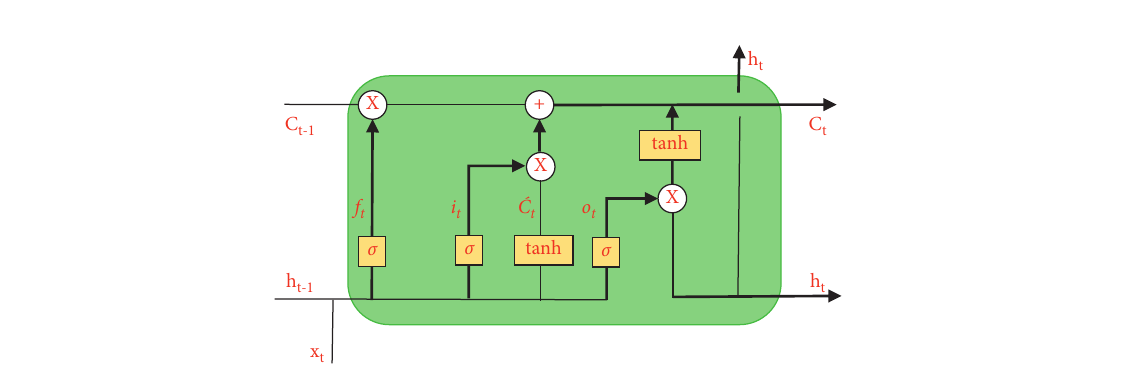
Figure 1: The architecture of long short-term memory